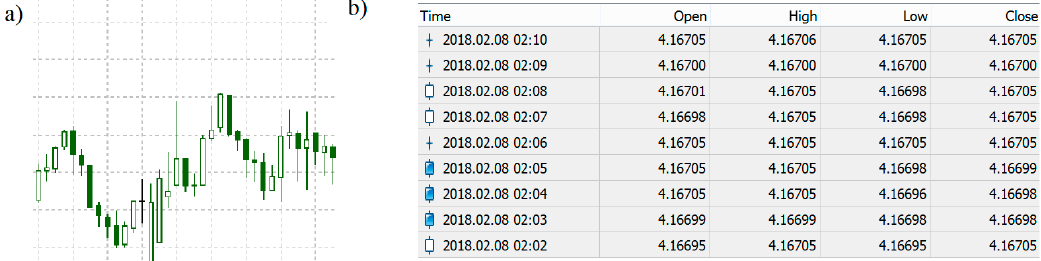
Figure 1. Candlestick representation of the course: ( a ) plot ( b ) data format.